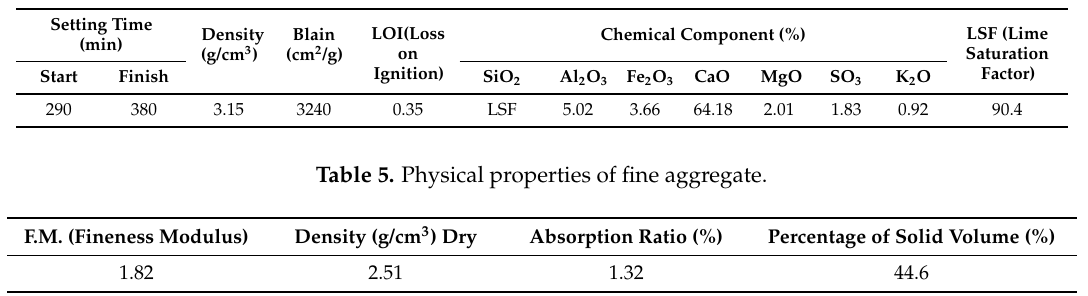
Figure 2. Curing process in this study: ( a ) traditional two-step curing process; ( b ) modified one-step curing process.